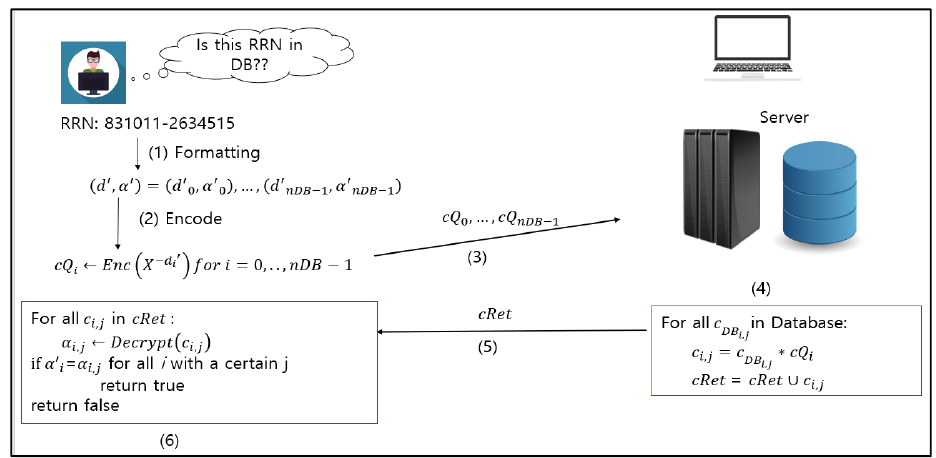
Figure 6. Search Figure 6. Search protocol.